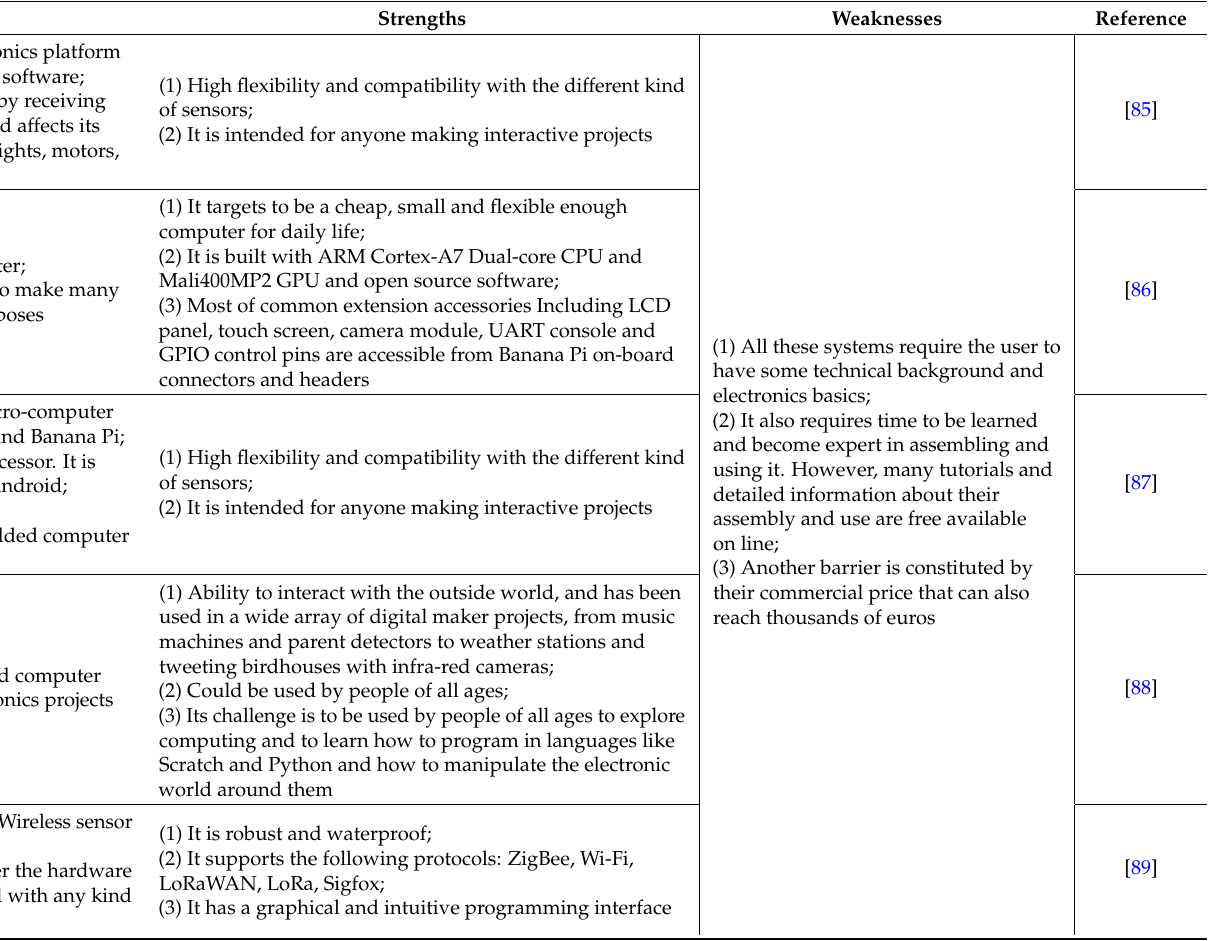
Table 5. Strengths and weaknesses of the analyzed